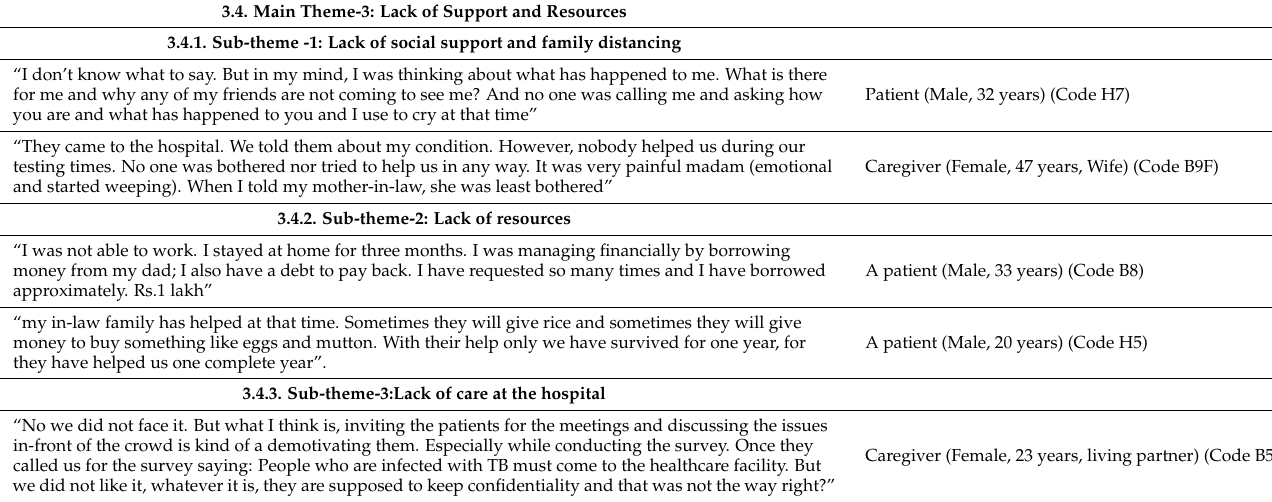
Table 4. Quotes reflective of theme “lack of support and resources” and its